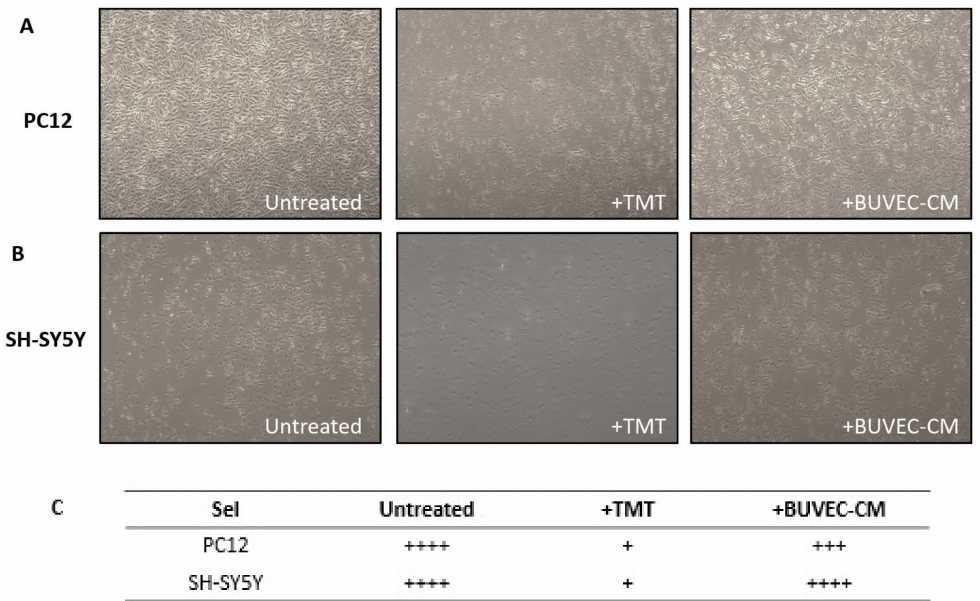
Figure 1. ( A ) Rat pheochromocytoma PC12 cell lines and ( B ) SH-SY5Y cell lines morphology assess- ment after treatment with BUVEC-CM and neurotoxic agent TMT ( C ) Semiquantitative measurement for the cell density. Compared with untreated cells, treatment with 10 µ M TMT (+ TMT, in the absence of BUVEC-CM) significantly reduced the cell density, indicating a reduction in cell viability and cytotoxicity induced by TMT. Interestingly, treatment with BUVEC-CM (+ BUVEC-CM) inhibited the reduction in the cell population induced by TMT. Images were taken with an inverted microscope (40 × magnification); + : a few; +++/++++: numerous). The morphological assessment of BUVEC-CM in rat pheochromocytoma PC12 and hu- man neuron-like SH-SY5Y cell lines was further revalidated and quantified in a spectrometry- based CCK-8 cell viability assay (Figure 2). Treatment of 1.5 × 10 6 cells/mL PC12 cells or 3 × 10 6 cells/mL SH-SY5Y lines with 10 µ M TMT (in the absence of BUVEC-CM) signifi- cantly reduced the CCK-8 cell viability indexes, represented by the reduction in the cell population, and indicated the cytotoxicity performed by TMT. According to the morpholog- ical observation, treatment of both cell lines with TMT and several dilutions of BUVEC-CM did not show a significant reduction in the CCK-8 indexes. The cell populations in all con- centration variants (25%, 50%, 75%, and 100%) of BUVEC-CM-treated cell lines, indicated by the CCK-8 indexes, remained high and about the same level when compared with the untreated cell lines (OD = 1.16577 for BUVEC-CM 25% + TMT; OD = 1.1729 for BUVEC- CM 50% + TMT; OD = 1.1919 for BUVEC-CM 75% + TMT, OD = 1.2359 for BUVEC-CM 100% + TMT versus 1.46043 ± SD for untreated PC12 cells; OD = 1.5673 for BUVEC-CM 25% + TMT; OD = 1.6766 for BUVEC-CM 50% + TMT; OD = 1.67993 for BUVEC-CM 75% + TMT, OD = 1.67307 for BUVEC-CM 100% + TMT versus 1.9308 ± SD for untreated SH-SY5Y cells). There was no significant difference in CCK-8 indexes between each dilution variant of the BUVEC-CM-treated cell lines. The treatment with BUVEC-CM in both cell lines maintains cellular viability despite the presence of the proapoptotic TMT